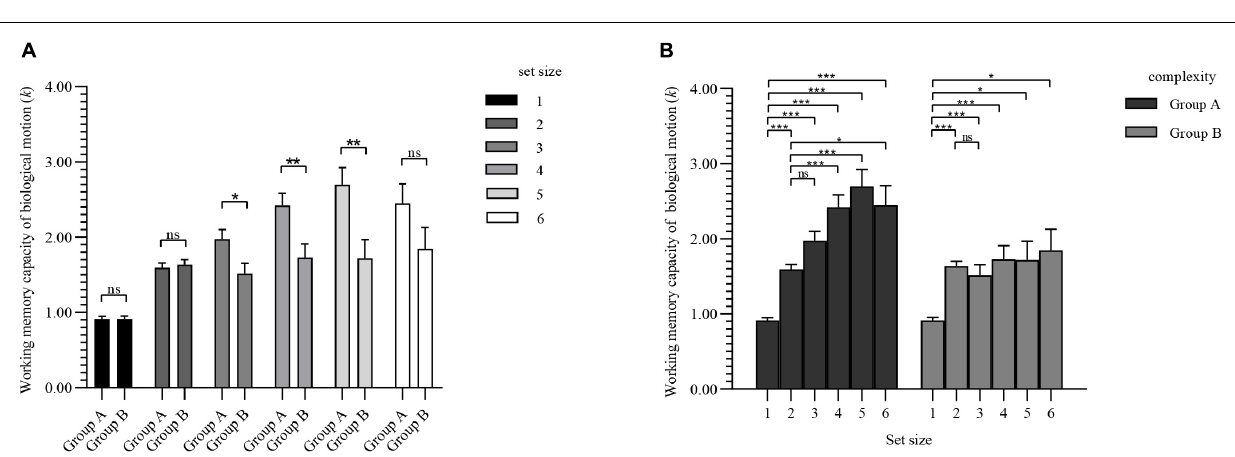
FIGURE 6 | Simple effect results of experiment 3. Values are reported as mean ± standard error. The Bonferroni method was used for multiple test correction. (A) Comparison of BM WMC for two complexities under different set sizes. (B) Comparison of BM WMC for set sizes under different complexities. ns: not significant; * p < 0.05; ** p < 0.01; *** p <